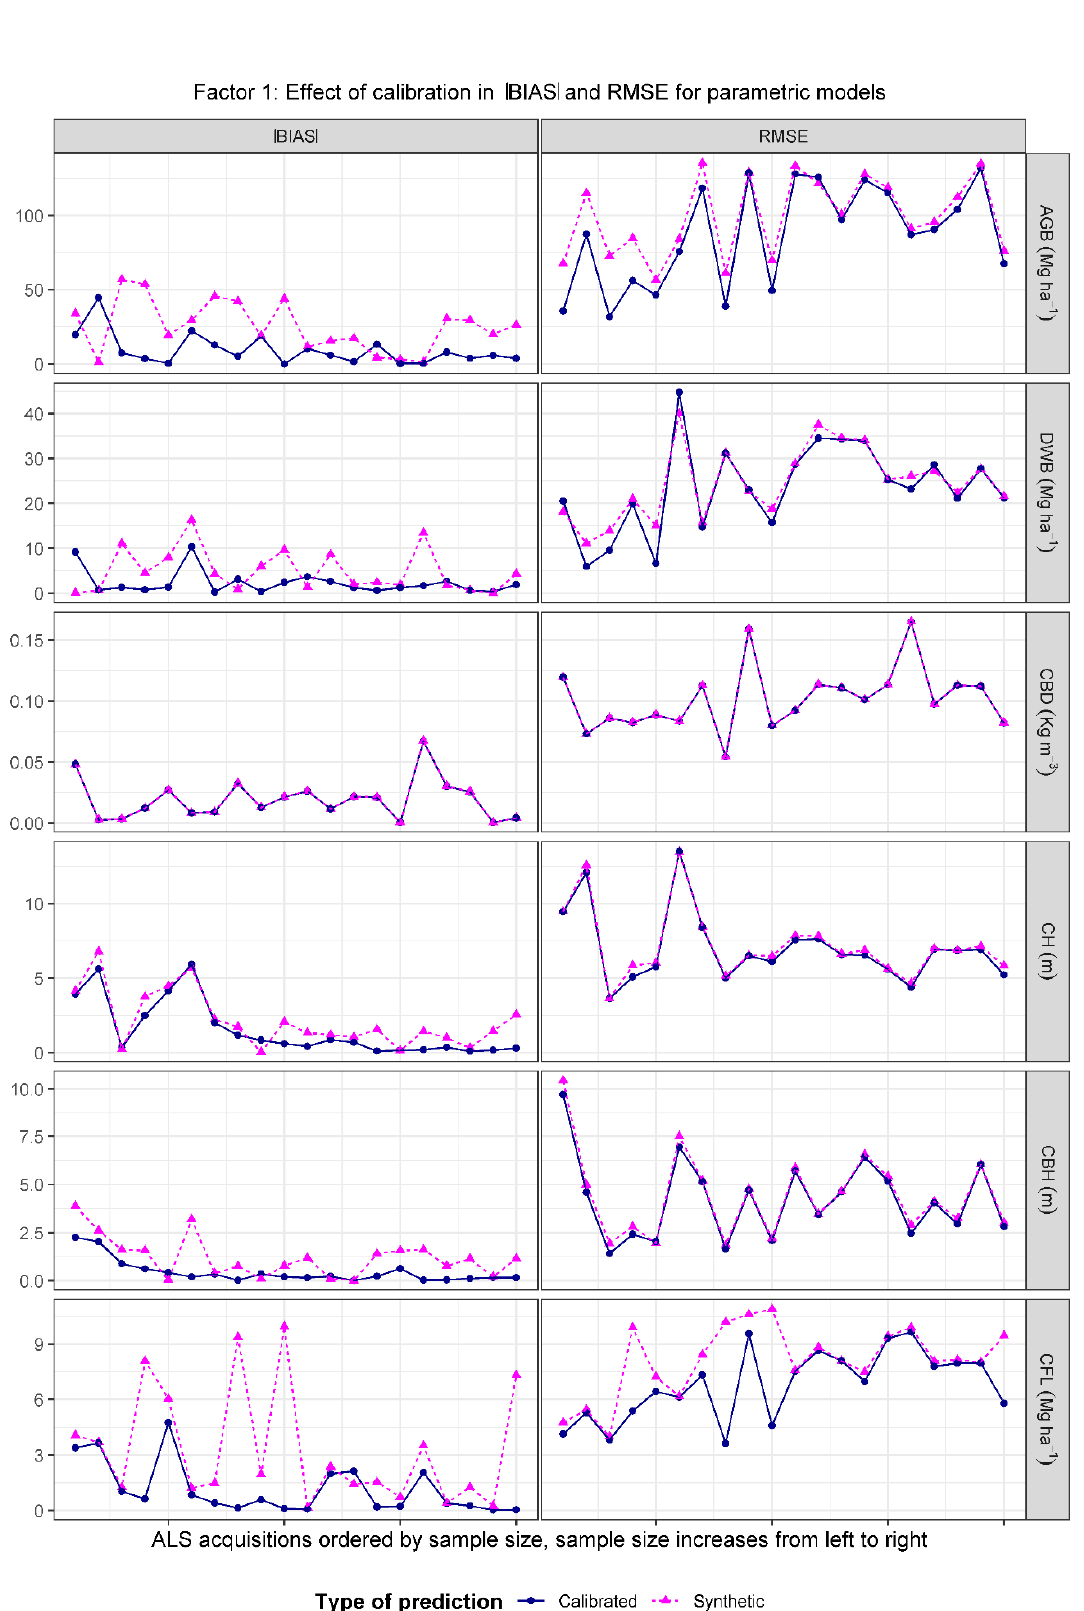
Figure A3. ALS-acquisition-specific BIAS and RMSE for synthetic and calibrated predictions for parametric and models. AGB, DWB, CBD, CH, CBH and CFL respectively indicate aboveground biomass, downed woody biomass, canopy bulk density, canopy height, canopy base height, and canopy fuel load.